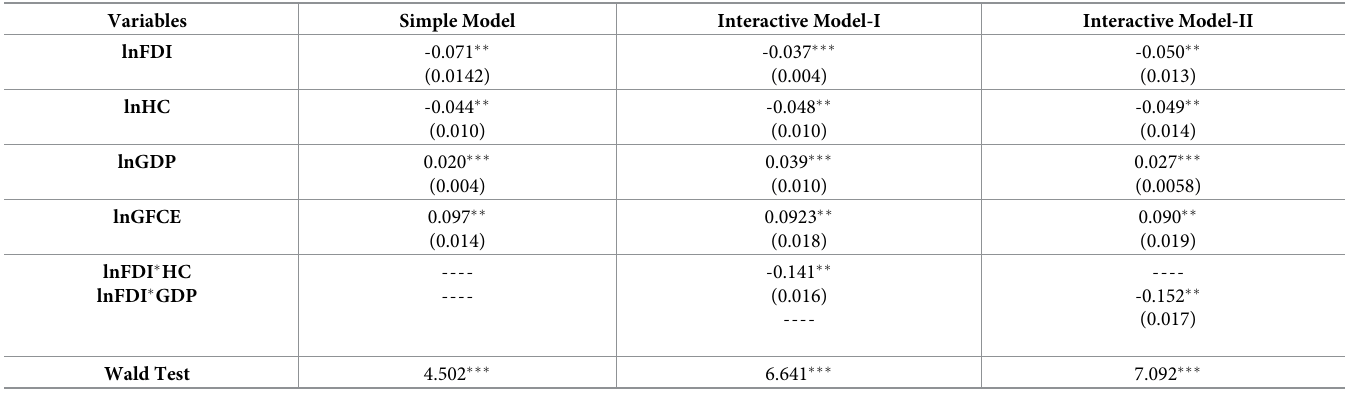
Table 5. AMG estimator. Variables